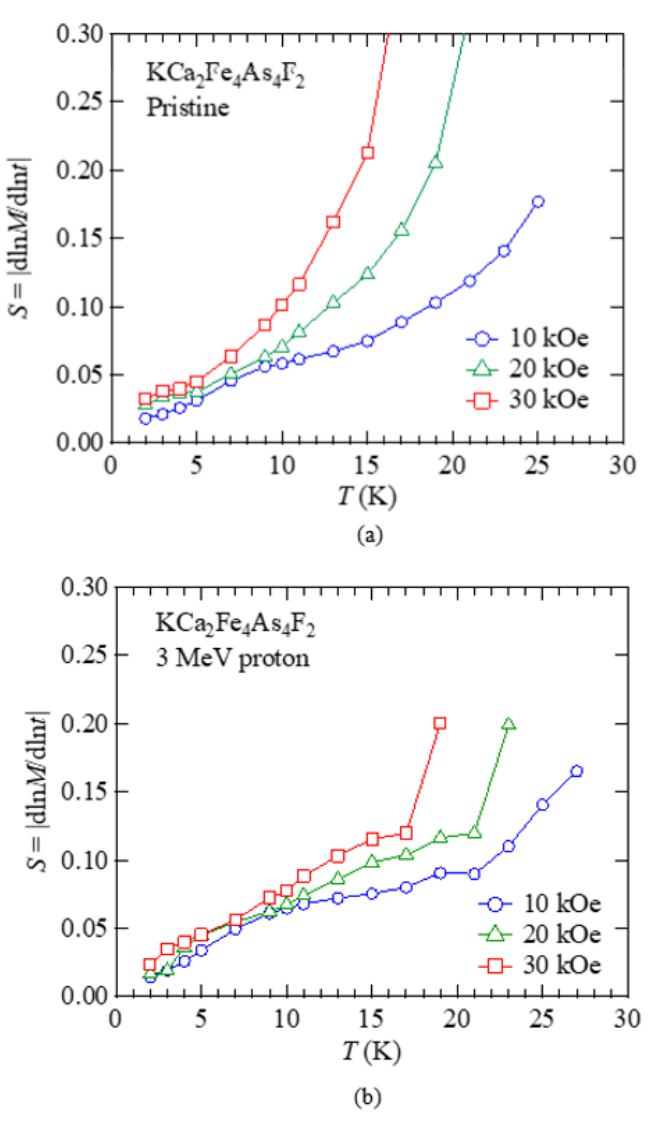
Figure 7. Temperature dependence of the normalized magnetic relaxation rate S at H = 10, 20, and 30 kOe under H // c in ( a ) the pristine and ( b ) 3 MeV proton irradiated (3 × 10 16 ions/cm 2 ) KCa 2 Fe 4 As 4 F 2 .